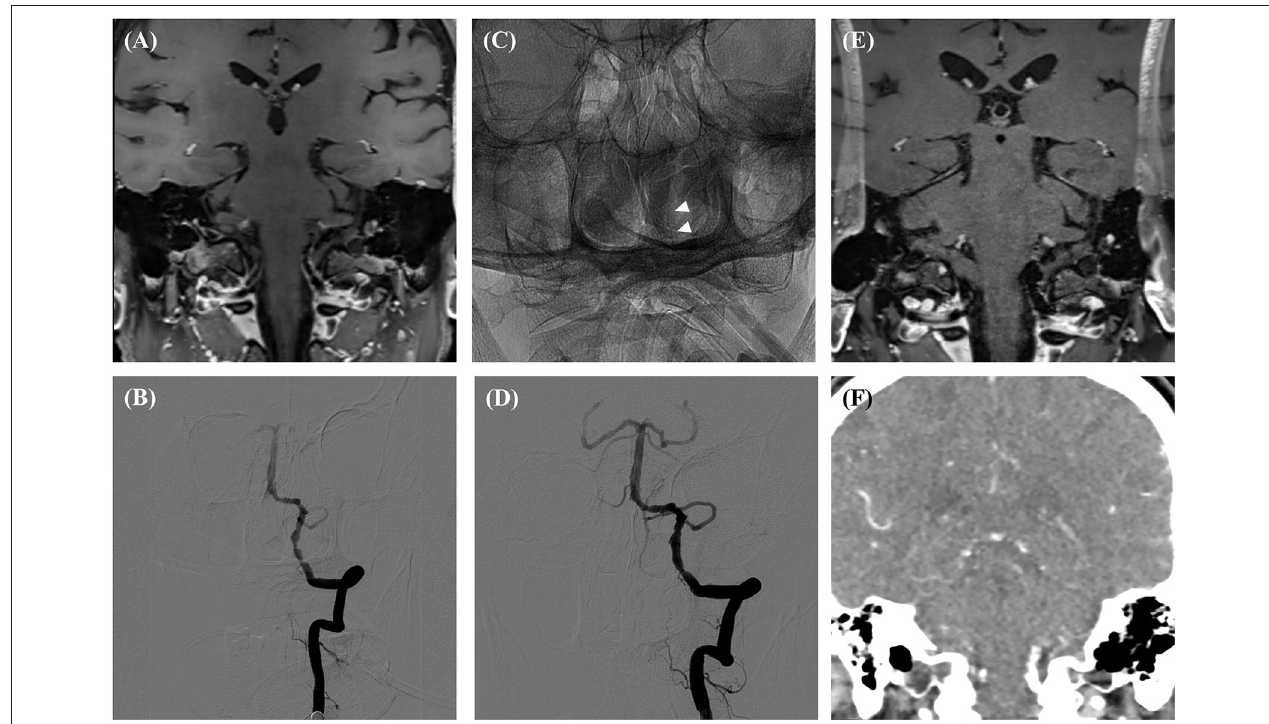
FIGURE 2 | Preprocedural HR-MR (A) , Preprocedural DSA (B) , DSA immediately after the procedure (C,D) , follow-up HR-MR (E) and CTA (F) . There was a signal drop at the level of the vessel in the follow-up HR-MR images. White arrows showed the Apollo stent.